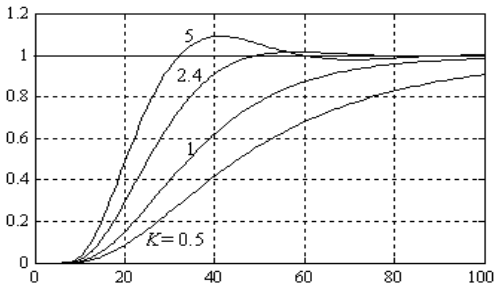
Figure 19. Responses y ( t ) to a unit step reference for T F = 4 and K = 0.5; 1; 2.4; 5.